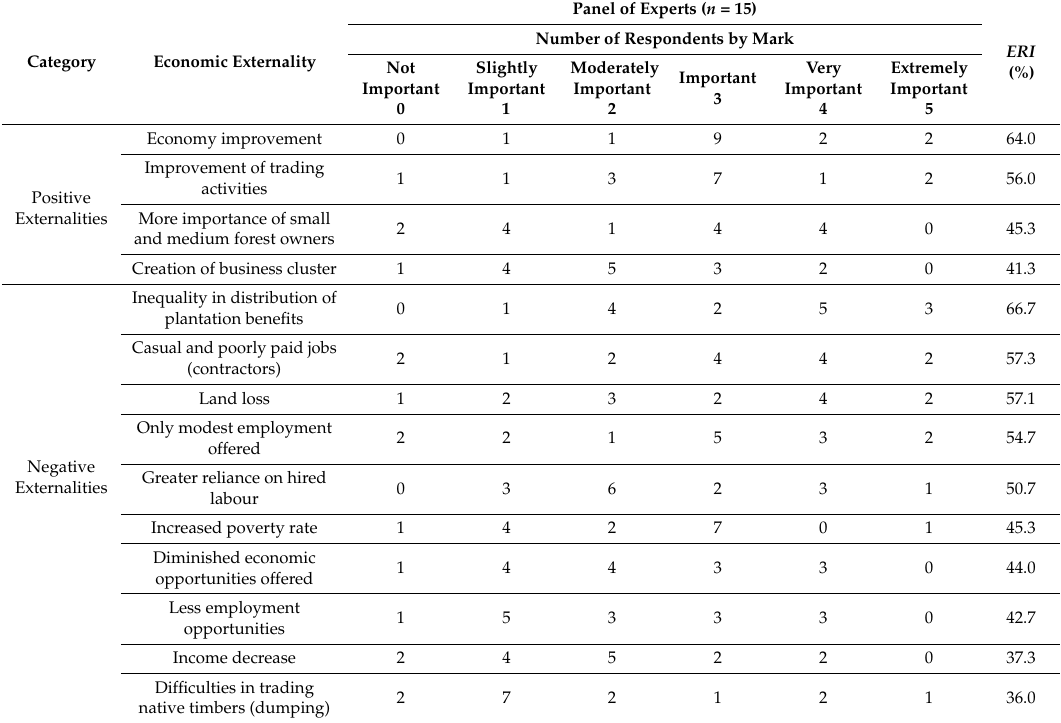
Table A4. Frequency of the Likert scale per externality and relative scores of economic externalities according to the experts’